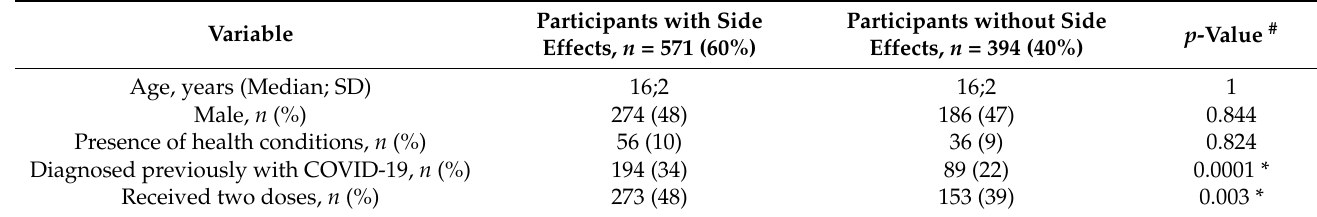
Table 3. Univariate analysis of the participants who presented with side effects compared to those without side effects following COVID-19